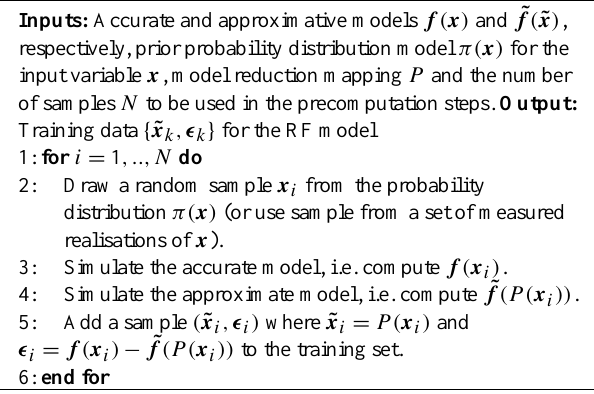
Algorithm 1 : Simulation of training